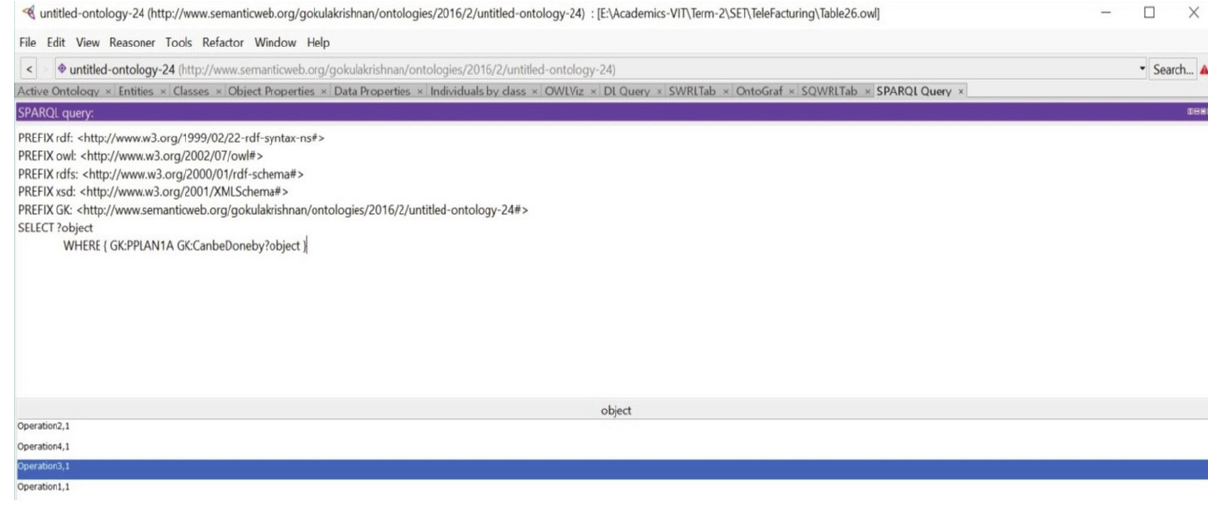
Figure 5: Generation of SPARQL query.